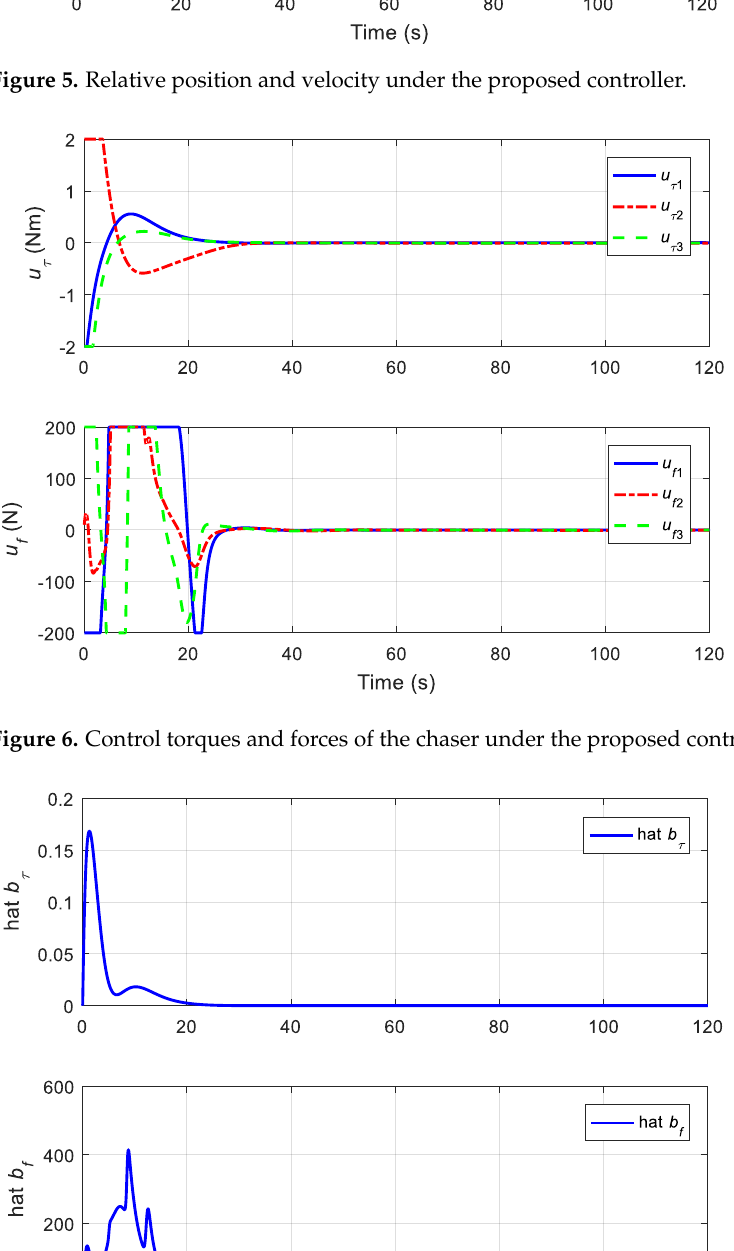
Figure 8. Relative attitude and angular velocity under the PD controller.